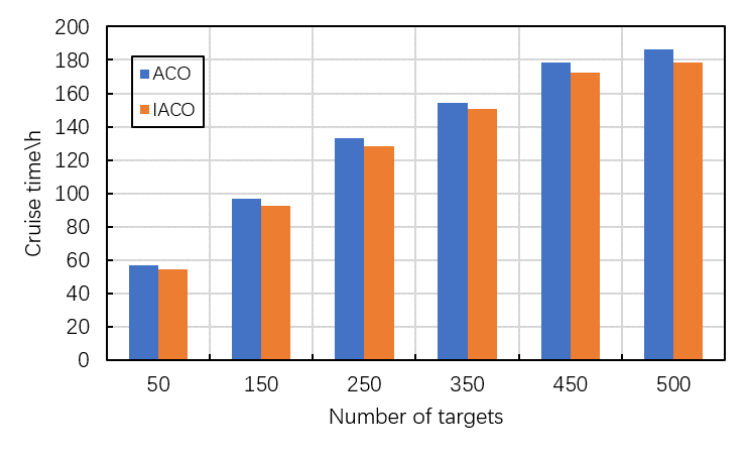
Figure 9. Cruise time of the airship in 6 cases with different numbers of targets obtained by